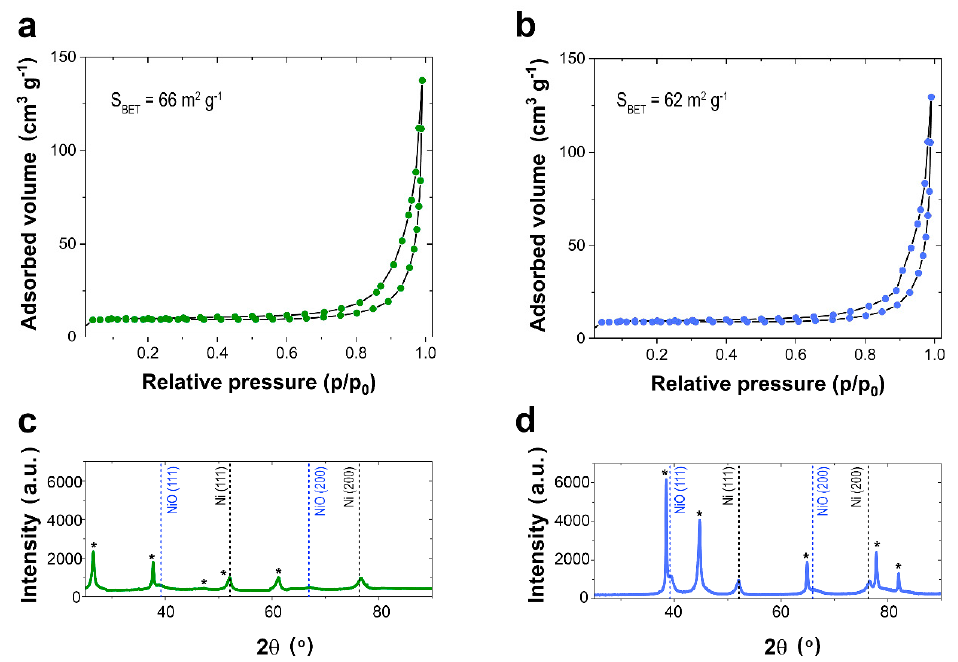
Figure 6. ( a , b ) Nitrogen adsorption and desorption isotherms and ( c , d ) XRD patterns of Ni-rich Ni- mesoporous films prepared at − 1.3 V (vs. Ag | AgCl) on ( a ) FTO and ( b ) Si / Ti / Au substrates. The Pt mesoporous films prepared at − 1.3 V (vs. Ag|AgCl) on ( a ) FTO and ( b ) Si/Ti/Au substrates. The